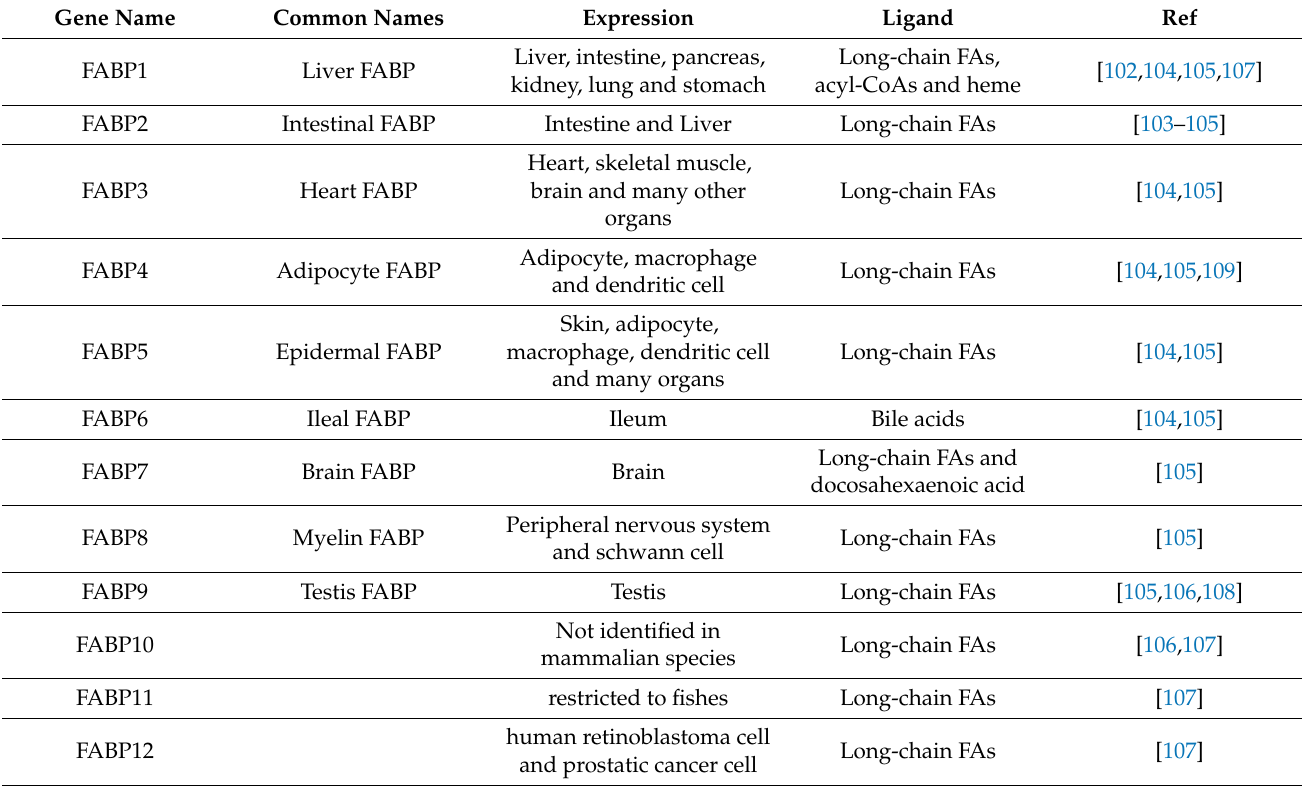
Table 1. FABP family members and their